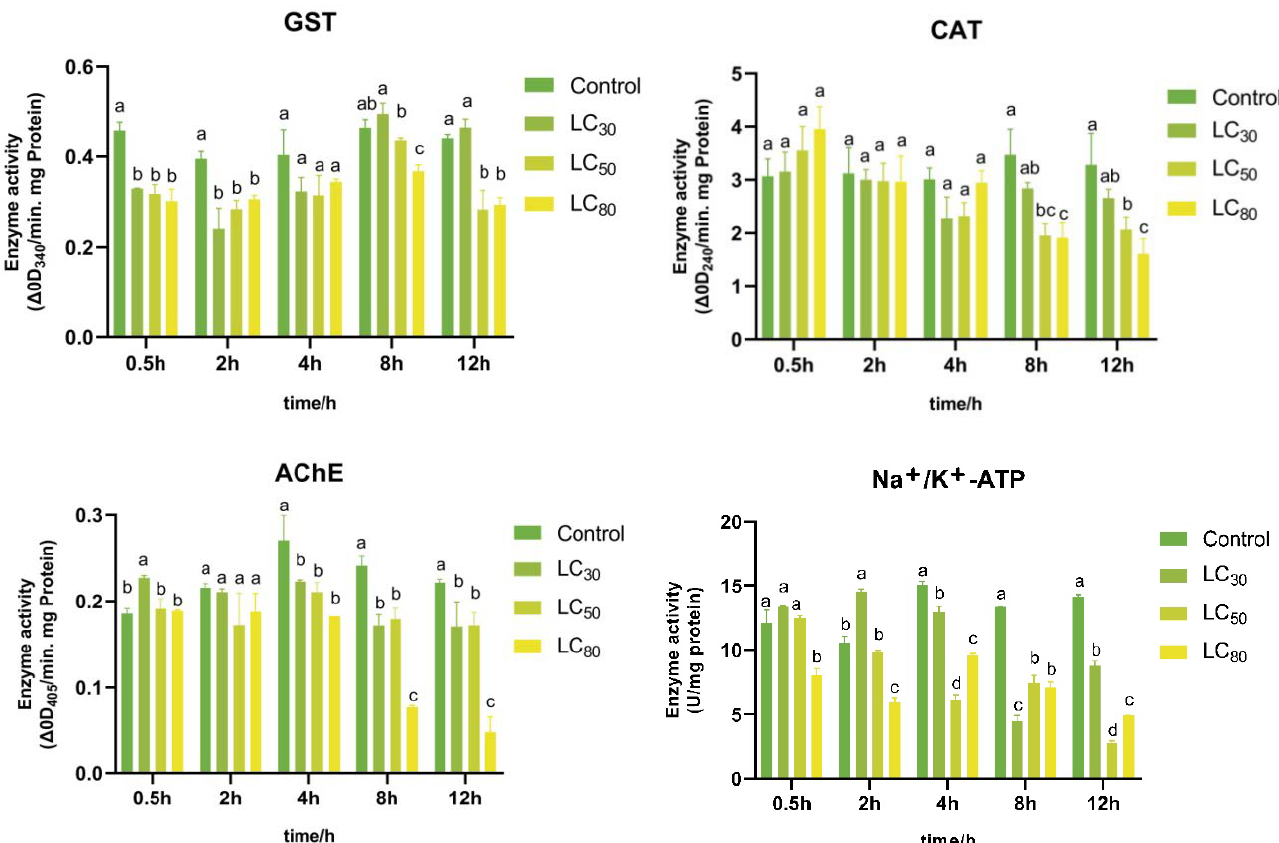
Figure 5. Effect of (-)-4-terpineol on enzyme activities of P. xylostella adults after fumigation. In each enzyme activity chart, bars followed by the same letter in each time interval are not significantly different using Tukey’s HSD test at p < 0.05. Units used: GST (Glutathione S-transferase): CDNB conjugated product/mg protein/min, CAT (Catalase): Remaining amount of H 2 O 2 /mg protein/min, AChE (Acetylcholinesterase): 1.3.5-trinitrobenzene (TNB) product/mg protein/min, Na + /K + -ATPase: 1 μmol inorganic phosphorus product/mg protein.